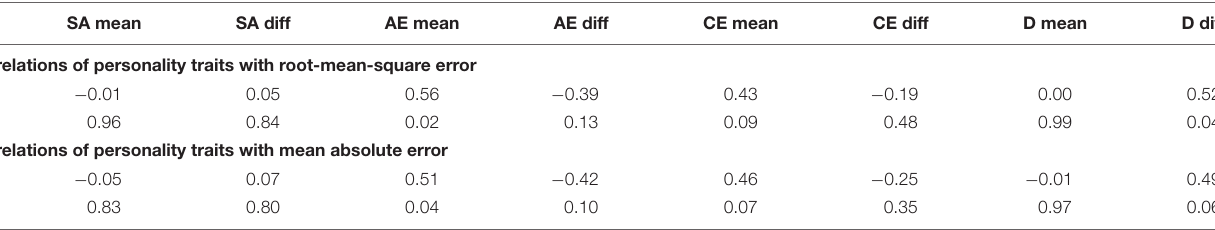
TABLE 4 | Correlations between engagement estimation errors and the means and differences in four personality traits in dyad-specific estimation.